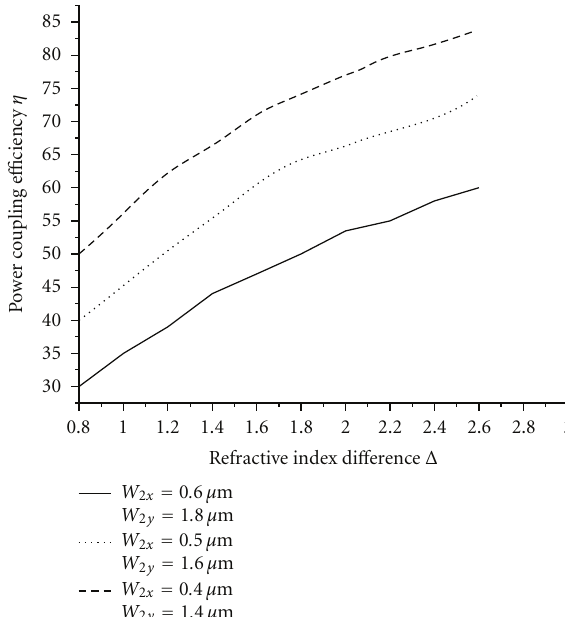
Figure 7: Power coupling e ffi ciency η is shown as a function of fibre relative core-cladding refractive-index di ff erence Δ in percent for three di ff erent spot sizes fo the Gaussian beam at its waist, the wavelength of the beam, λ = 0 . 86 μ m and n 1 = 1 . 45.